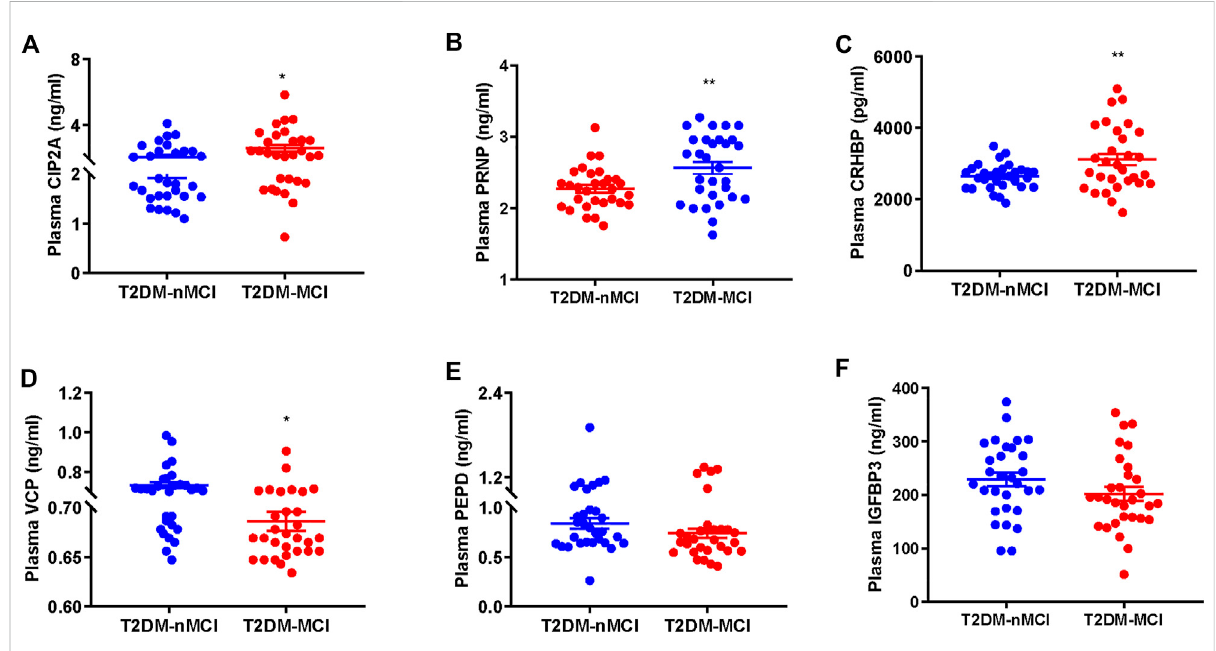
FIGURE 4 Validationofproteomics-identi fi edplasmacandidatebiomarkersbyELISA. (A – F) Levelsofplasma-derivedCIP2A (A) ,PRNP (B) ,CRHBP (C) ,VCP (D) , PEPD (E) , and IGFBP3 (F) in T2DM-nMCI and T2DM-MCI. *p < 0.05 and **p < 0.01 vs . T2DM-nMCI